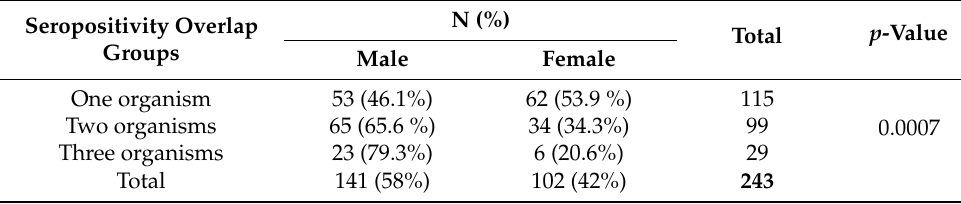
Table 2. Association between seropositivity overlap groups and